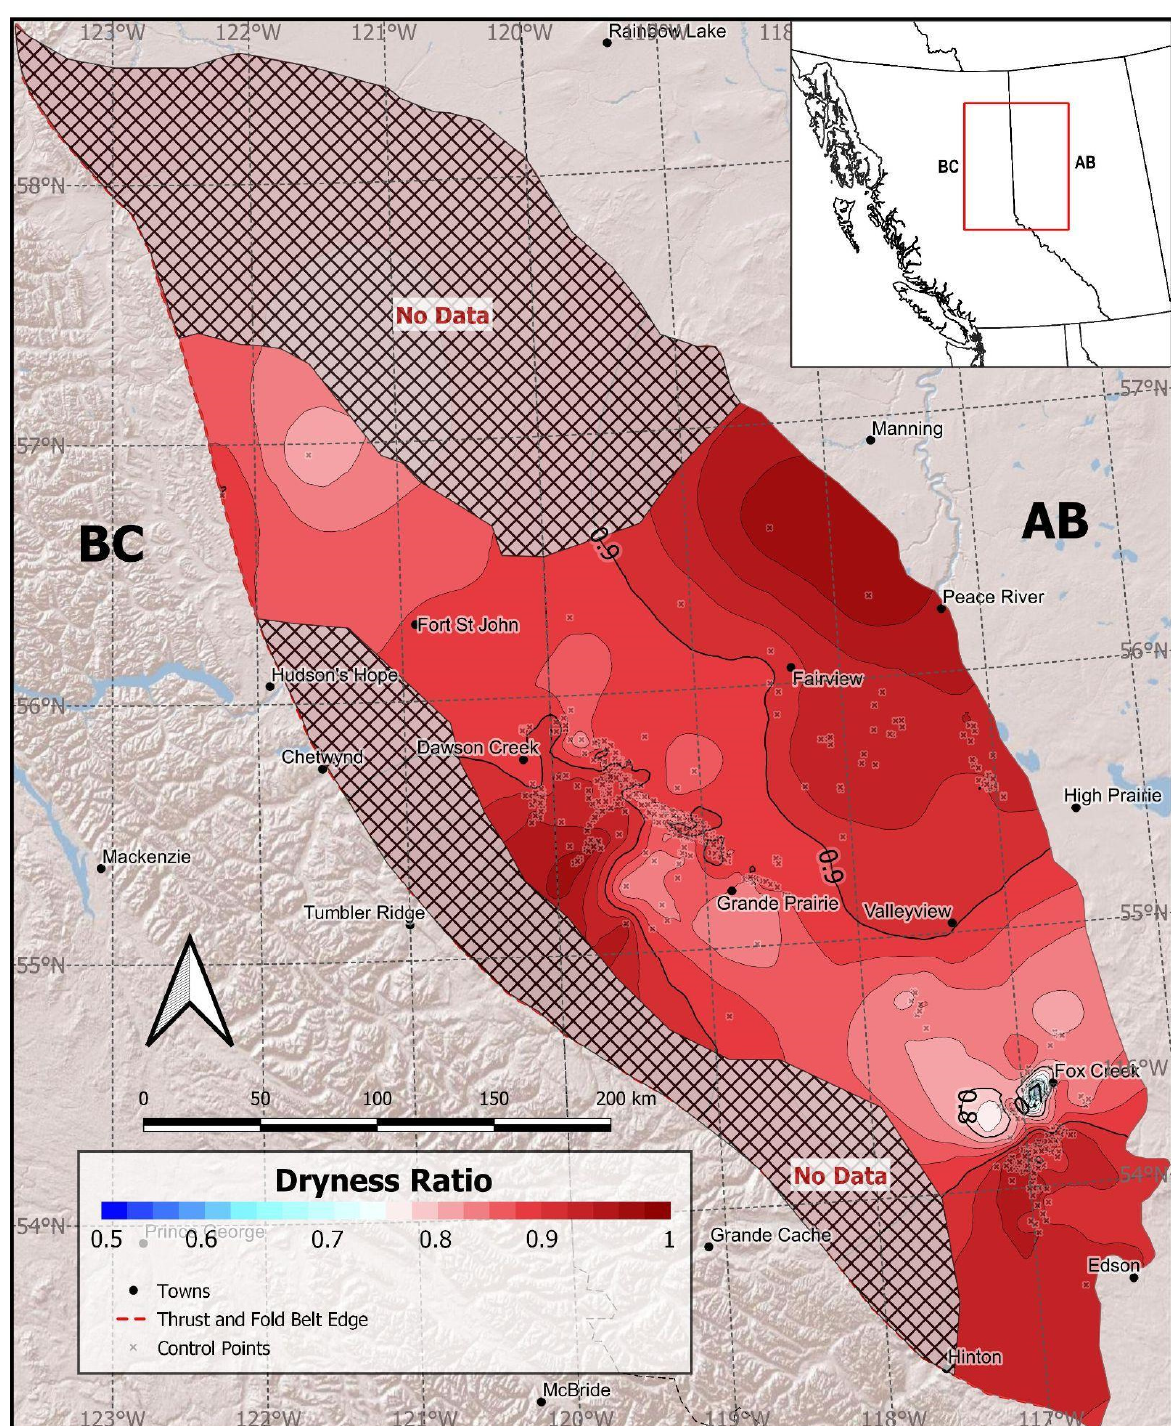
Figure 26. The distribution of the gas dryness ratio on the Middle Montney Formation. A similar gas dryness pattern was observed from individually mapping the Upper and Middle Montney Formation subzones.